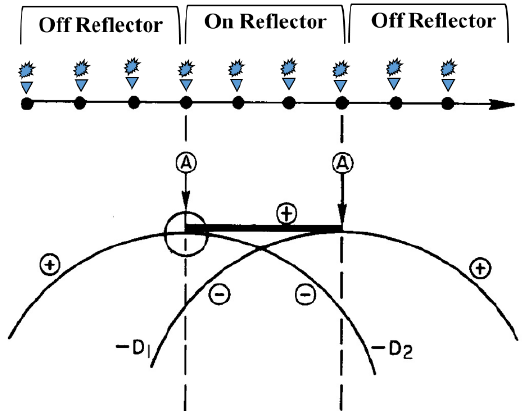
Figure 1. Graphical representation of the diffraction phenomenon with the geometry of the source and receiver functions produced at the edges of the reflectors (D1 and D2). A phase change of 180° is shown on either side of the curves.[16]